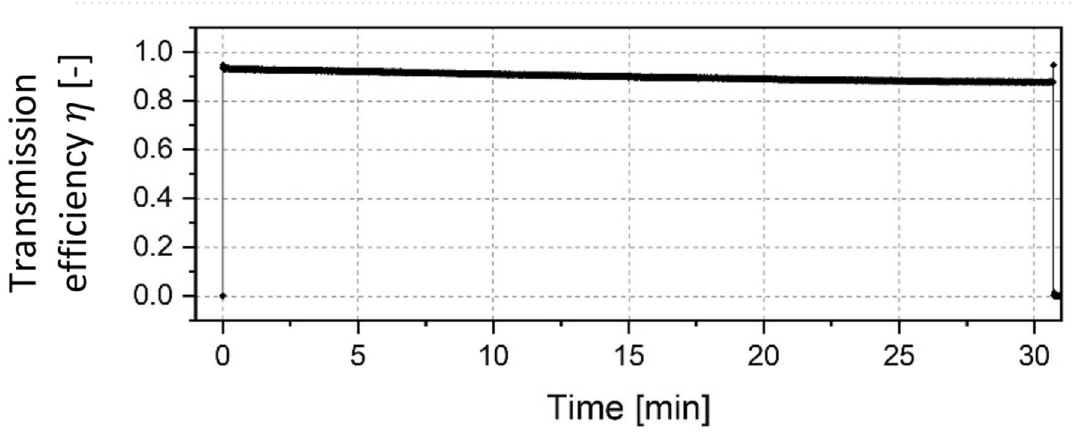
Figure 5. Normalized current transmitted through a 270° glass capillary with a primary particle energy of 14.5 keV.